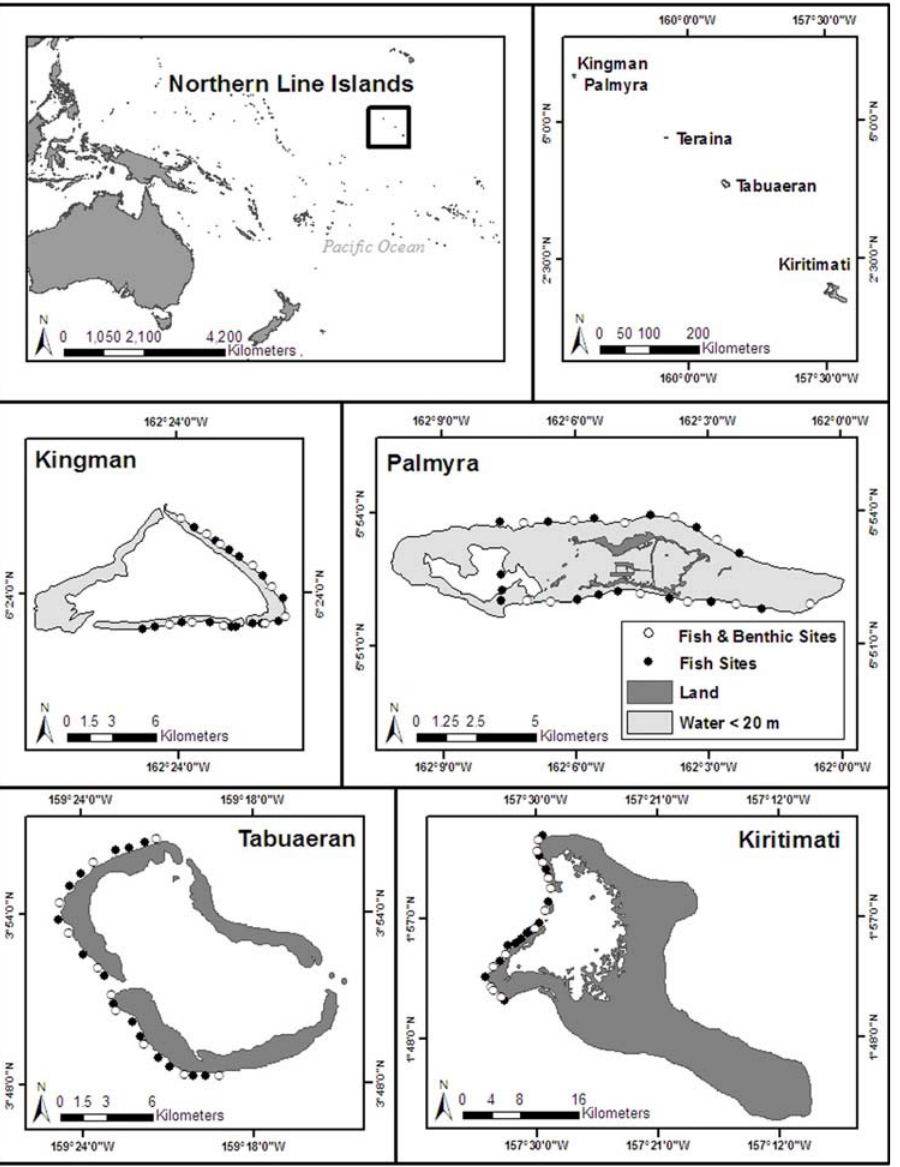
Figure 1. Location of study sites at Kingman, Palmyra, Tabuaeran and Kiritimati atolls in the Line Islands. Sites were located at semi- exposed fore reef habitats between 10 and 12 m in depth, and approximately one km apart from each other. Reef fishes were surveyed at all sites (n=25 sites per atoll), and benthic communities at a subset of sites (n=10–12 sites per atoll).